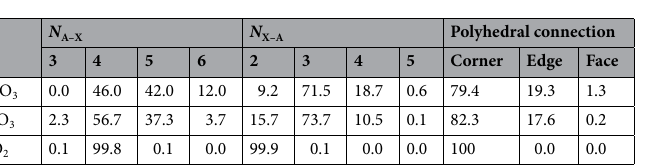
Table 1. Coordination number distributions and polyhedral connections in g -Al 2 O 3 , l -Al 2 O 3 , and g -SiO 2 .